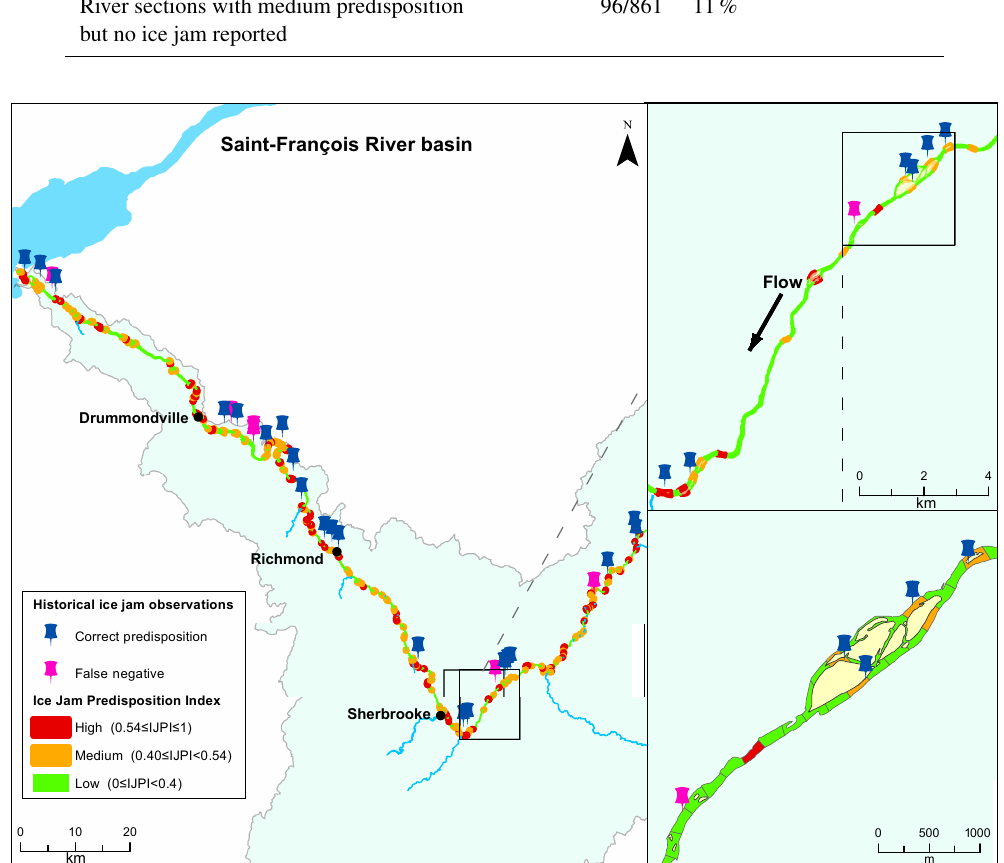
Figure 7. Map of the model results on the Saint-François River, over 250m sections. Thumbnails are the locations of reported ice jams. Blue is used when the ice jam falls on a section with a moderate to high predisposition (correct assessment). Magenta is used when the ice jam falls on a section with a low predisposition (false-negative